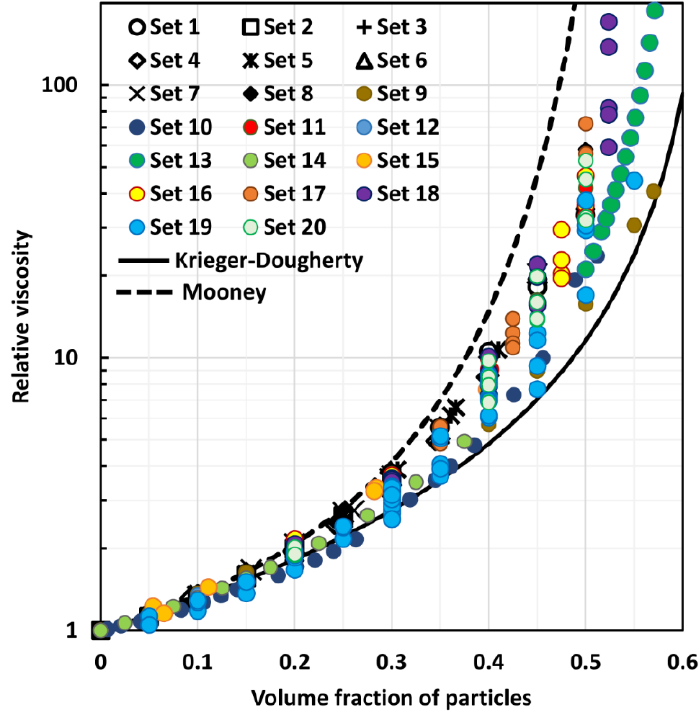
Figure 7. Comparison of experimental viscosity data for suspensions of non-Brownian hard spheres with the predictions of Mooney and Krieger-Dougherty equations ( φ m = 0.637 ) .